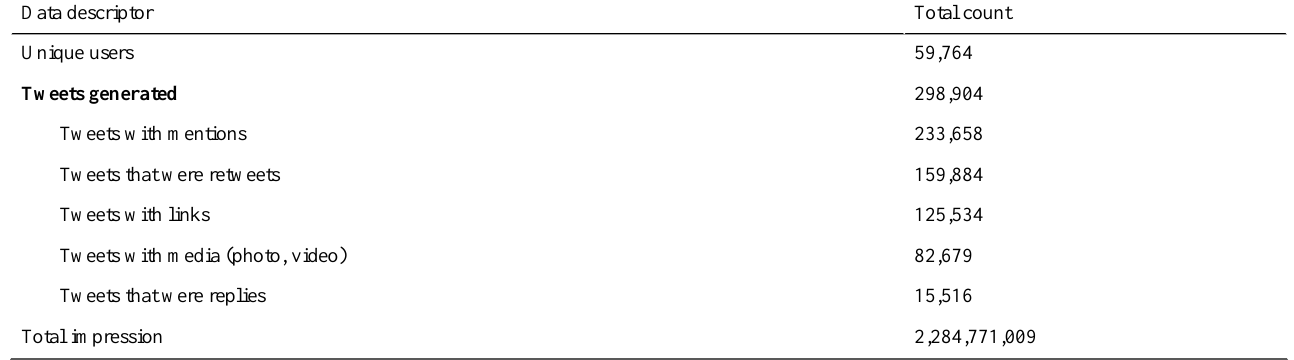
Table 1. Key #BTSM user and tweet descriptors for 2012-2018.